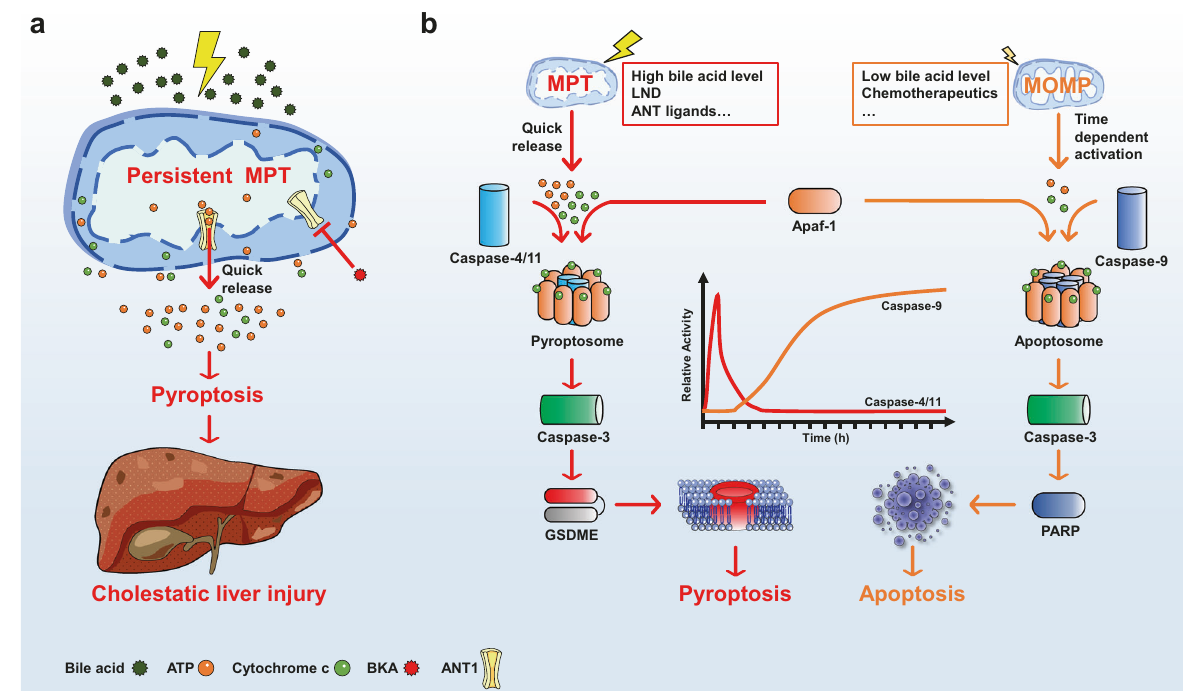
Fig. 1 Bile acids activate MPT-triggered pyroptosis by Apaf-1 pyroptosome and cause cholestatic liver injury. a Bile acids of high level activate persistent MPT to quickly release ATP and cytochrome c through channels such as ANT1 to promote pyroptosis and cause cholestatic liver injury. b A novel molecular mechanism that Apaf-1 senses MPT to activate caspase-4/11-caspase-3-GSDME signal axis to promote pyroptosis, while the apoptosis pathway was activated by MOMP